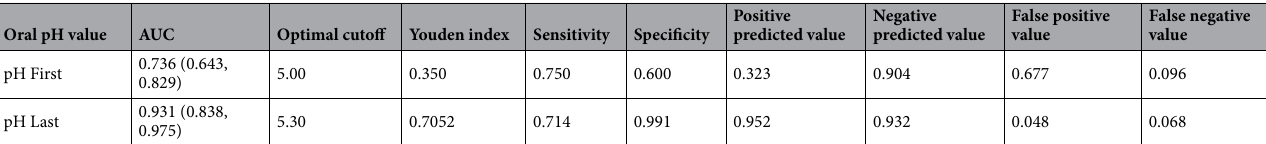
Table 4. Identification of the optimal oral pH value for the prediction of radiation-related caries by logistic regression model. RR: Pattern 1 versus Pattern 2; Pattern 1: oral pH value always > 5.3 or from < 5.3 to > 5.3; Pattern 2: oral pH value always ≤ 5.3 or from > 5.3 to ≤ 5.3.